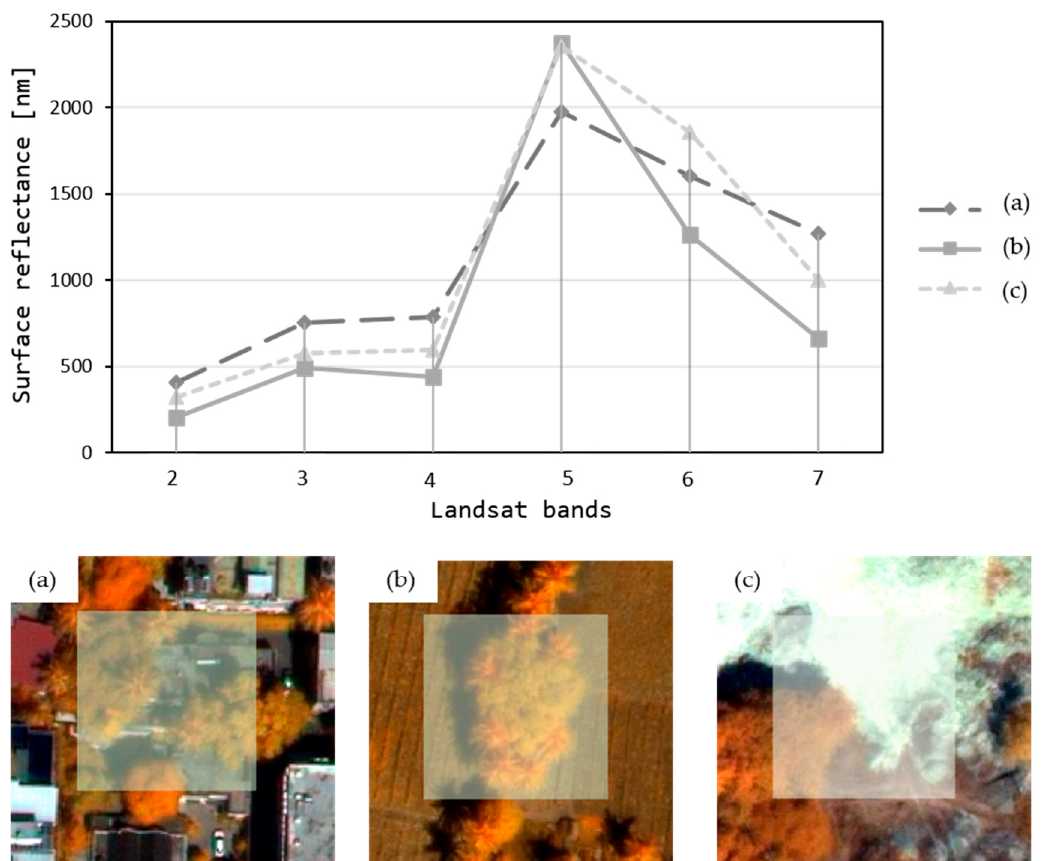
Figure 3. ( a – c ) WorldView-3 imagery with overlaying 30 m × 30 m Landsat pixel with 40% to 50% tree cover and (on top) the corresponding spectral signature.